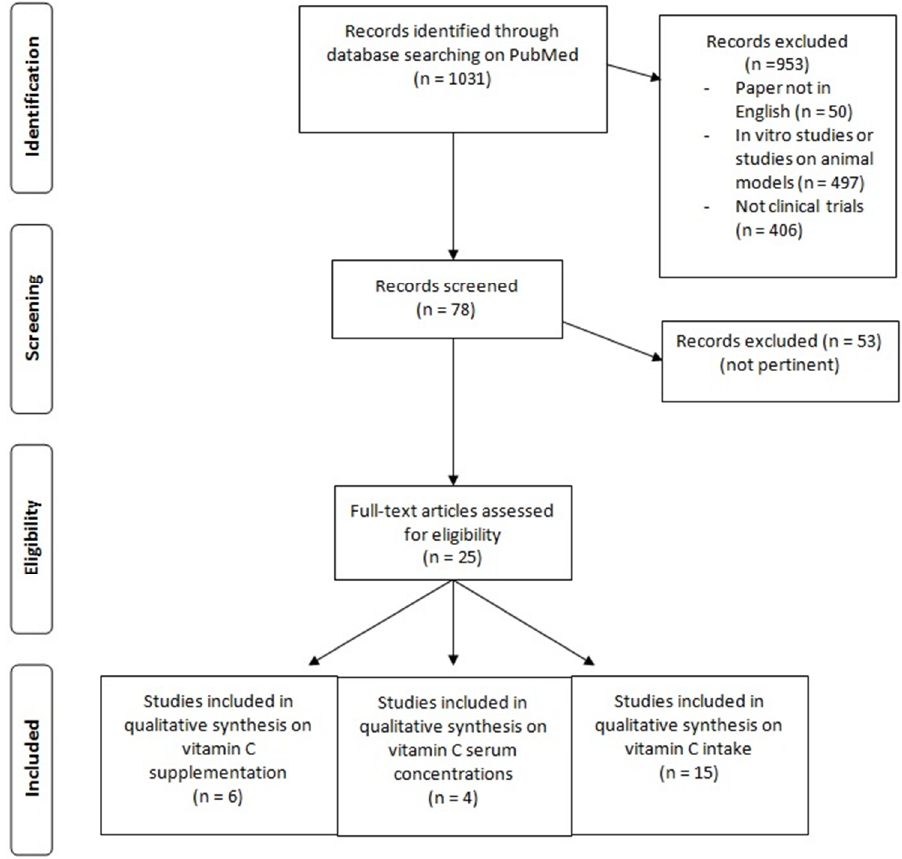
Figure 1. Flow chart of the literature research.